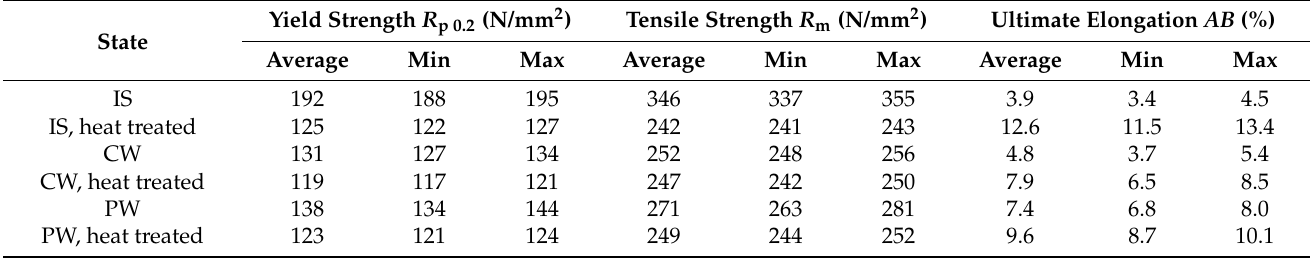
Table A2. Mechanical properties of the tensile specimens depending on the